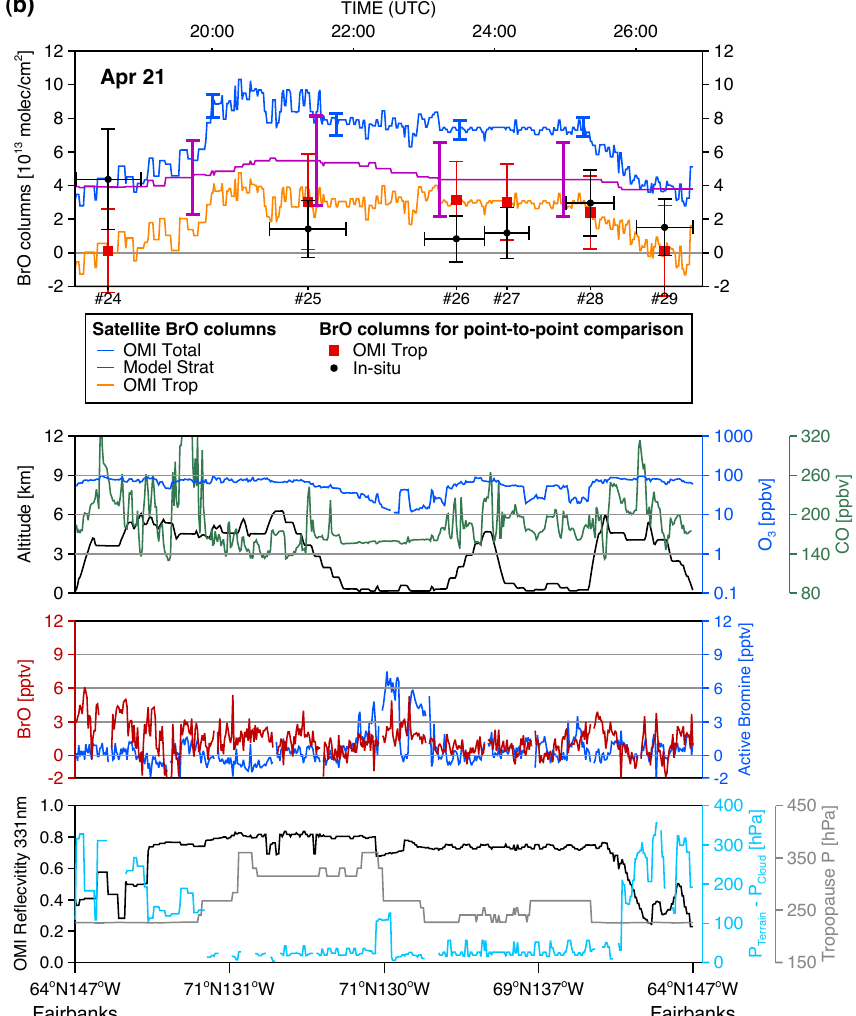
Fig. 10b. Similar to Fig. 9b but for the WP-3D flight on 21 April 2008, with tropopause pressure added (bottom